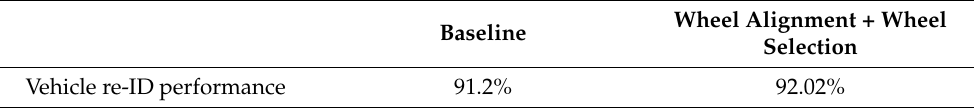
Table 2. Vehicle re-ID performance using detected